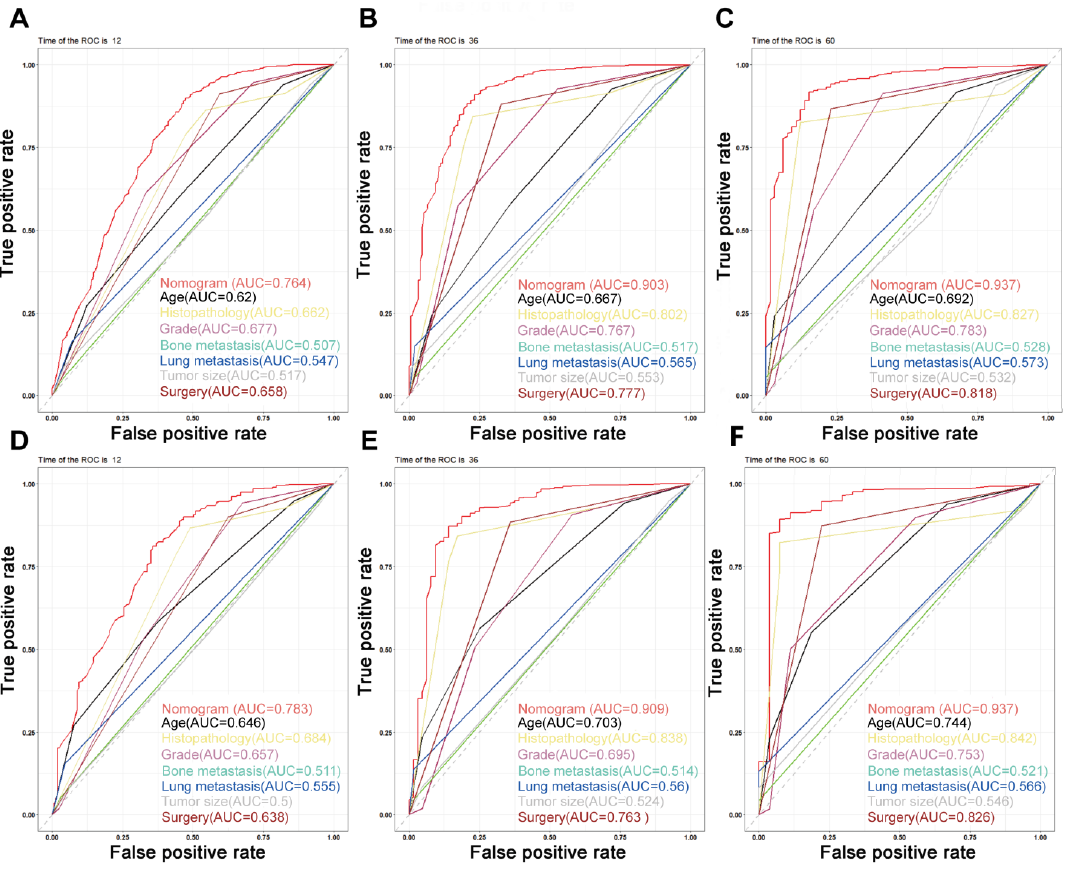
Figure 4. Time-dependent ROC curves. ( A – C ) Time-dependent ROC curves for the prognostic nomogram show AUC values of 0.764, 0.903, and 0.937 for predicting the 1-year, 3-year, and 5-year overall survival in the training cohort, respectively. ( D – F ) The AUC values were 0.783, 0.909, and 0.937 for predicting the 1-, 3-, and 5-year overall survival in the validation cohort, respectively.